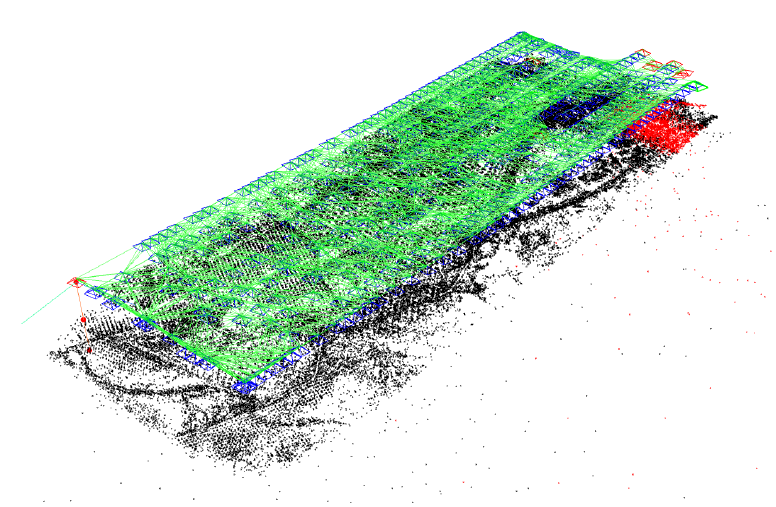
Figure 7. Execution until the last frame of GPS-SLAM with 6000